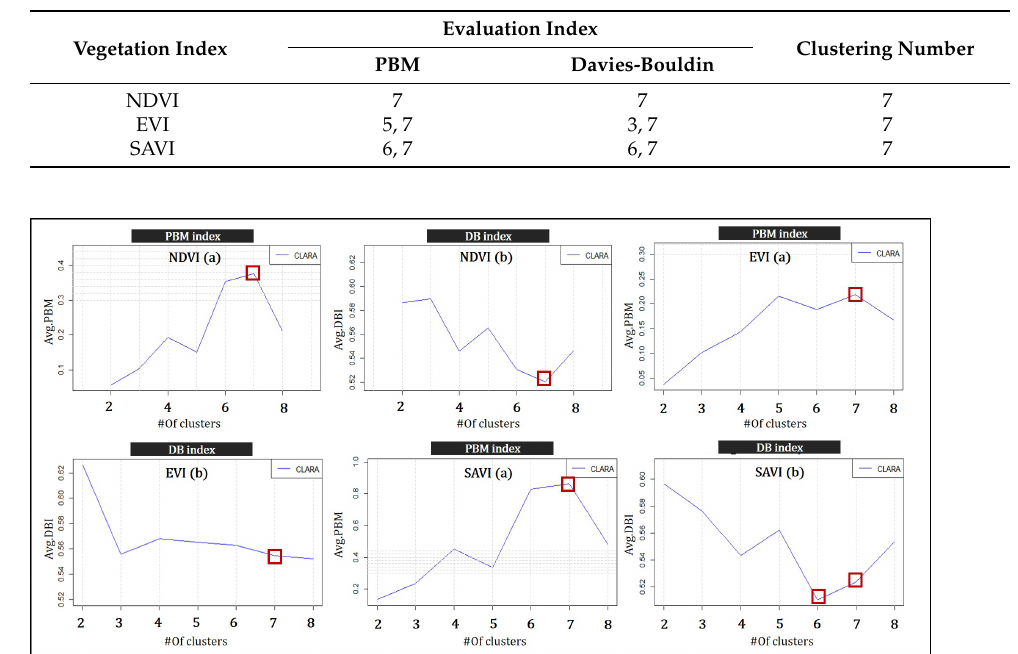
Table 5. Optimal number of clusters in the vegetation index.